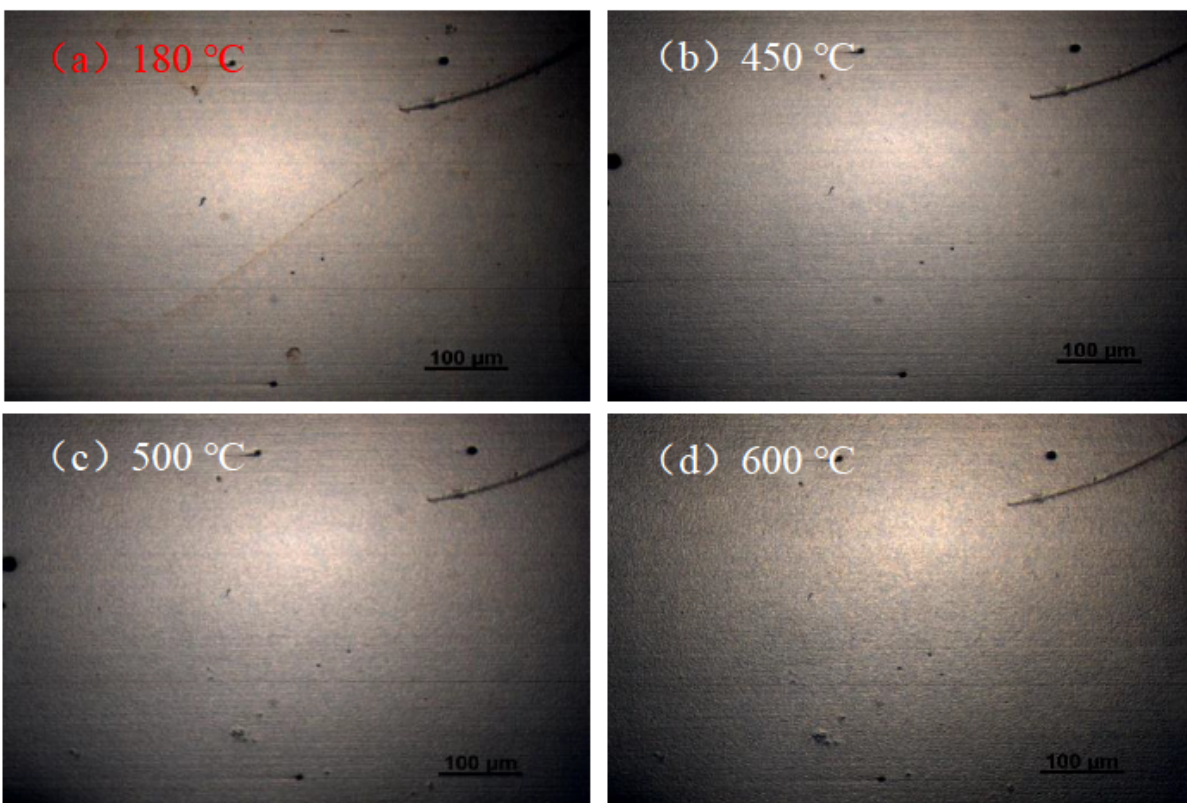
Figure 1: Surface morphology evolution during heating of the crystalline brazing filler metal at (a) 180, (b) 450, (c) 500 and (d) 600 ∘ C